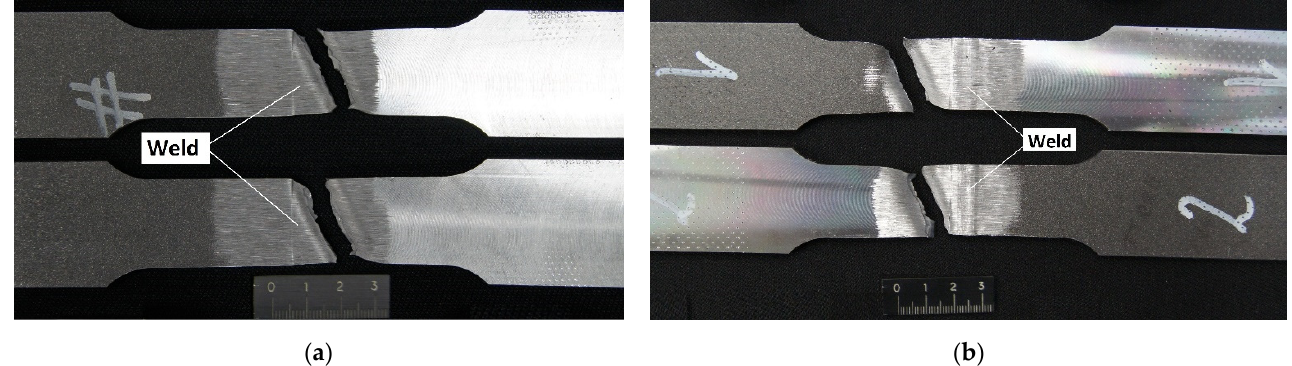
Figure 12. Specimens after the static tensile test of the HLAW joint: ( a ) joint no. 1 (PA) and ( b ) joint no. 2 (PC).